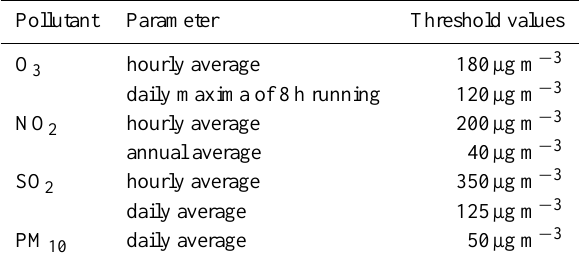
Table 2. Some regulatory European air quality thresholds of O 3 , NO 2 , SO 2 and PM 10 levels.